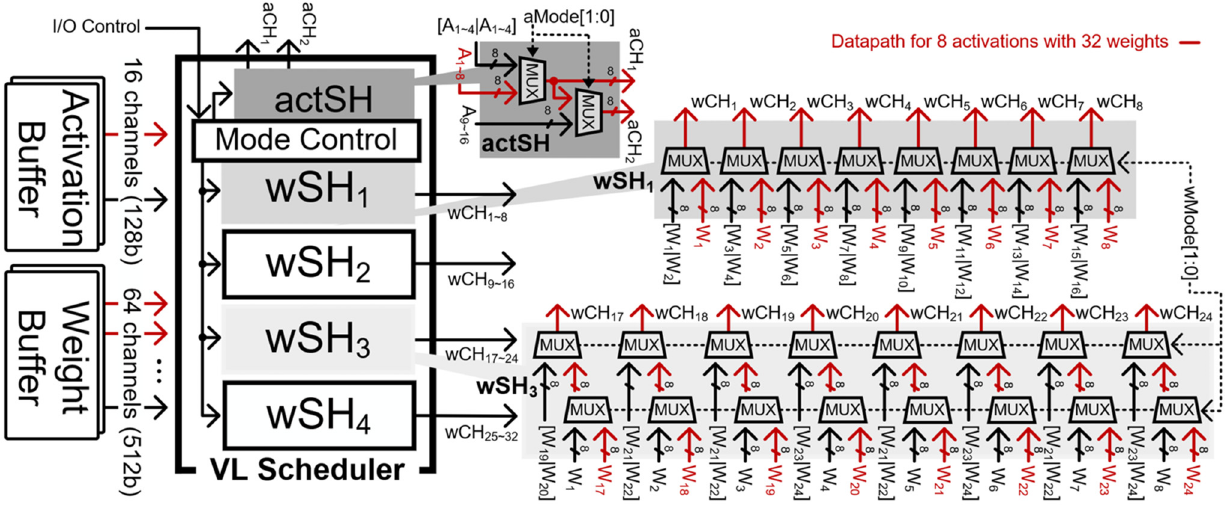
Figure 7. Architecture of the VL scheduler for multiplications of 8 activations and 32 weights.